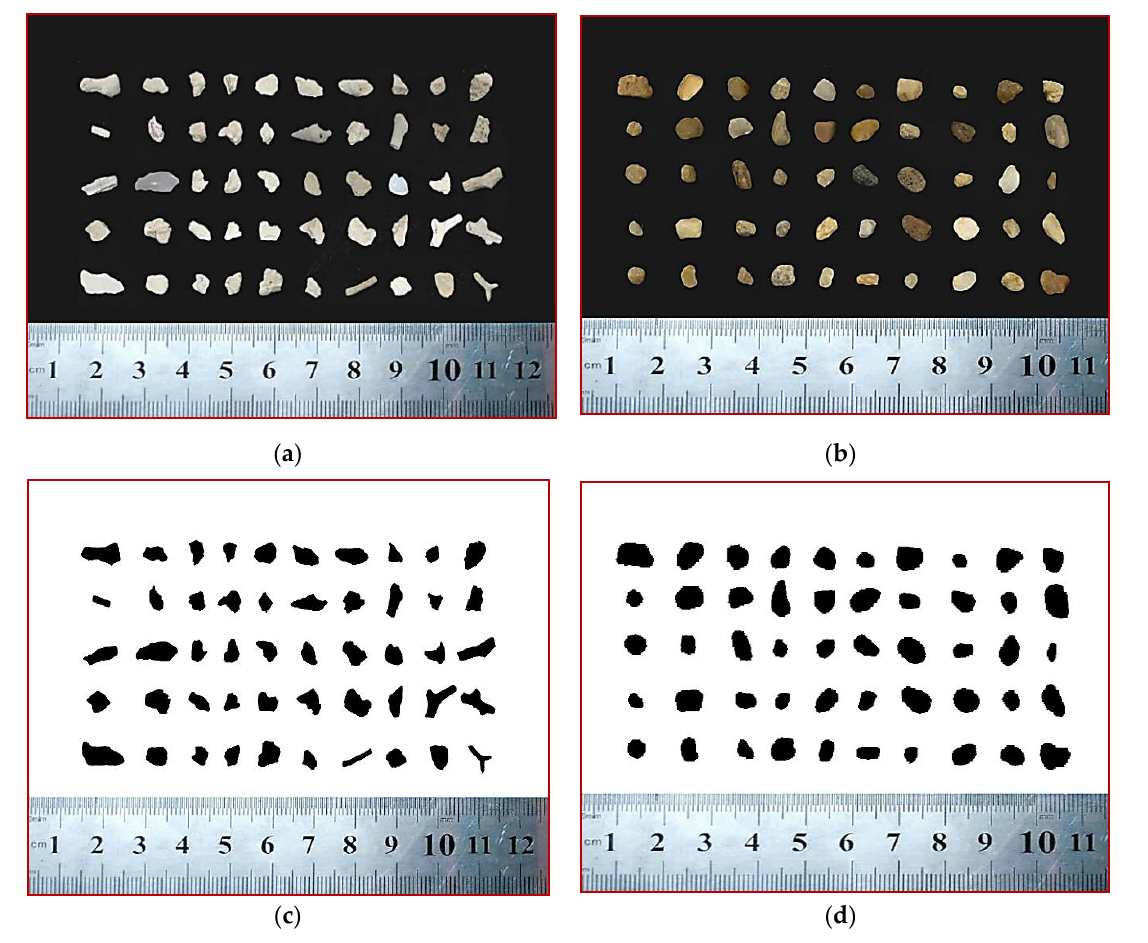
Figure 6. Digital images and black-and-white binarization images of coral sand and quartz sand with a diameter of 2.0–5.0 mm: ( a ) digital images of coral sand, ( b ) digital images of quartz sand, ( c ) black-and-white binarization images of coral sand, and ( d ) black-and-white binarization images of quartz sand.